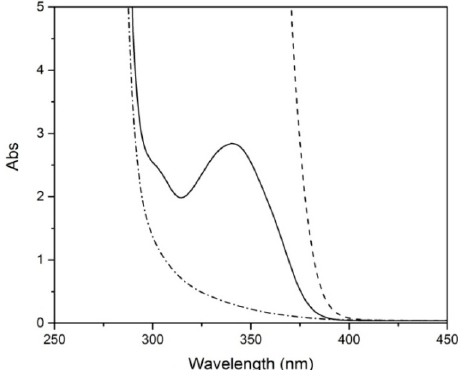
Figure 3. Infrared (FTIR-ATR) ( a ) and Raman ( b ) spectra of all the transparent and red samples, before artificial aging; all spectra present a similar profile, which corresponds to PMMA homopolymer.